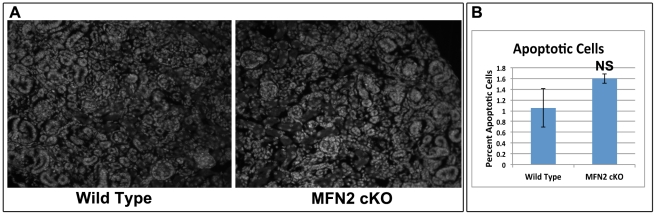
Effect of MFN2 conditional knockout on renal apoptosis.(A) Wide field fluorescent microscopy of kidney sections from wild type and MFN2 cKO four day old littermates stained with Hoechst dye injected intraperitoneally prior to sacrifice; remarkably few apoptotic cells were detected in either group. (B) Quantitative analysis of apoptotic cells in kidney sections of wild type and MFN2 cKO mice (n = 5/group). Data represent the mean and SD; * P>0.05.